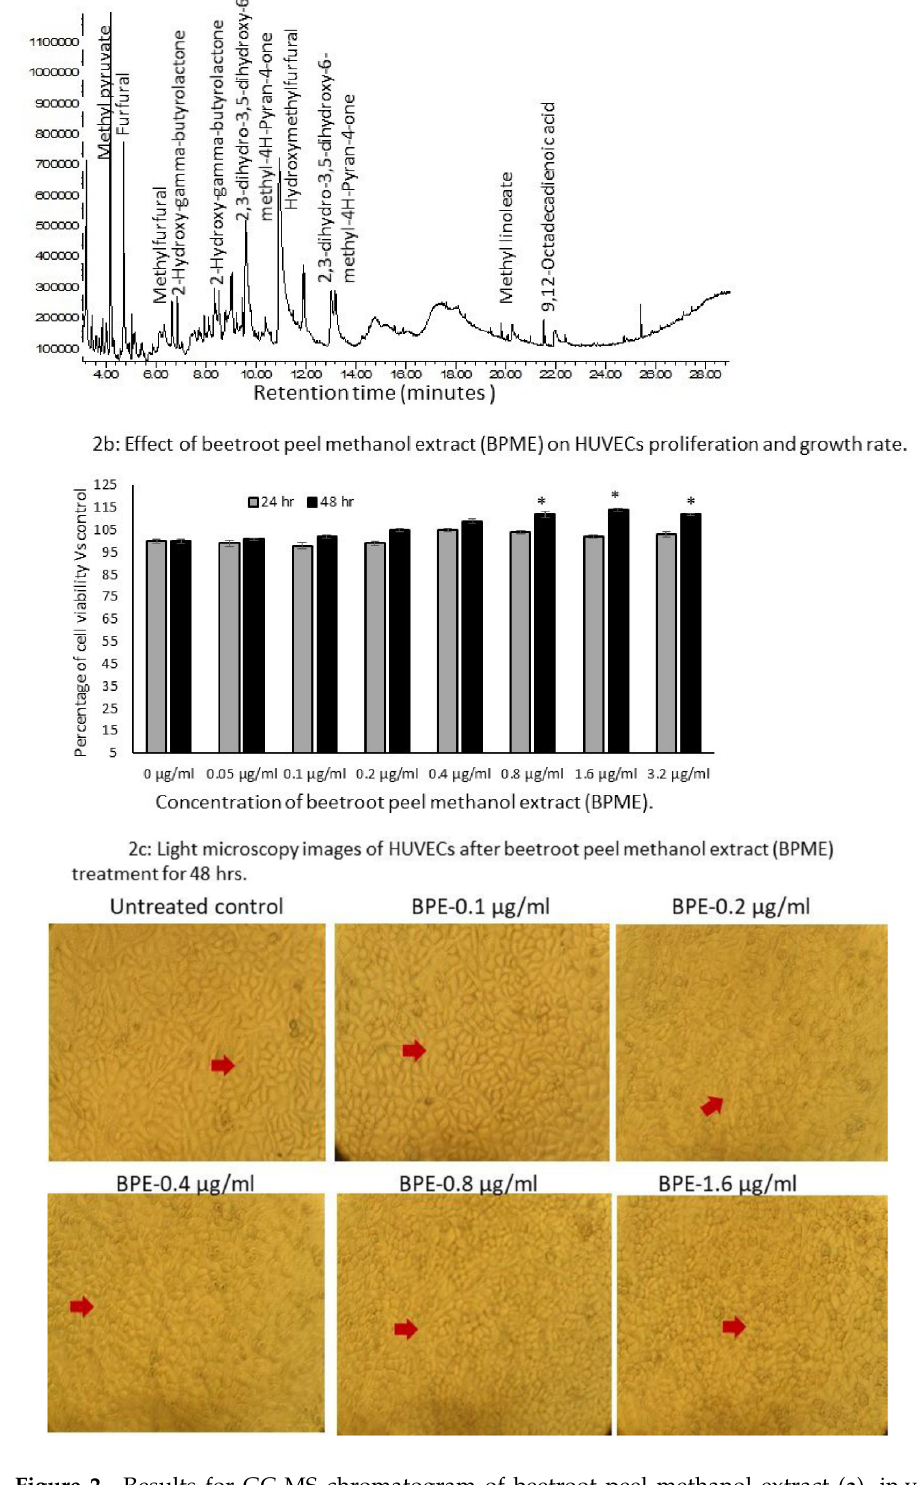
Figure 2. Results for GC-MS chromatogram of beetroot peel methanol extract ( a ), in vitro cell proliferation ( b ) and light microscopy images for cell morphology ( c ) in HUVECs treated with increasing concentration of beetroot peel methanol extract (BPME) (uniform shape of adherent and proliferating cells mentioned by red arrowhead). All values are means ± SD ( n = 6). * p ≤ 0.05 by comparison with vehicle